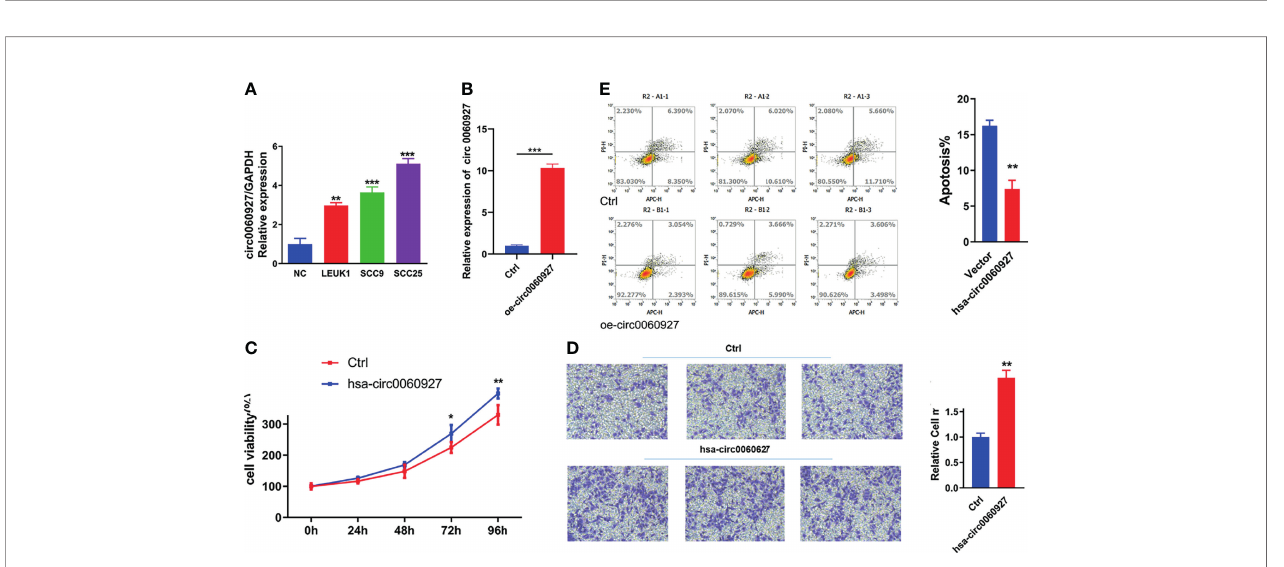
FIGURE 5 | Function analysis of has_circ_0060927. (A) The expression of has_circ_0060927 in NOM, LEUK1, SCC9, and SCC25 cells. (B) The expression change of has_circ_0060927 after transfection withhas_circ_0060927 overexpression plasmid. (C) CCK-8 assay. (D) Apoptosis assay. (E) Transwell assay. (** p < 0.01, *** p <